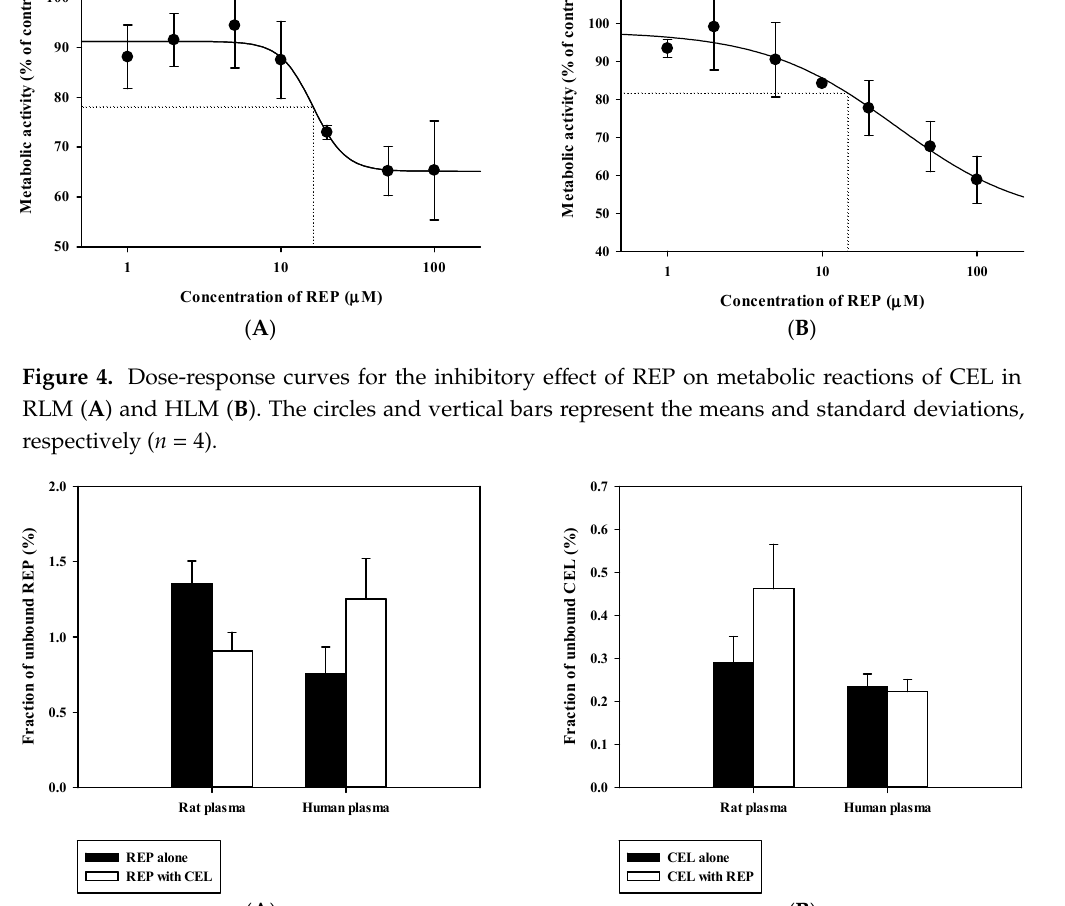
Figure 5. Fraction of unbound REP ( A ) and CEL ( B ) either alone or in combination in rat and human plasma ( n = 3).